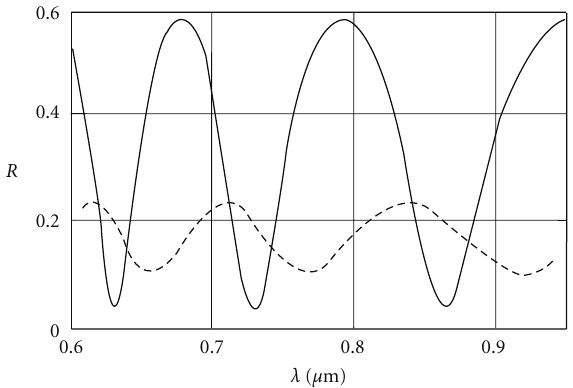
Figure 5: Reflectance spectrum of a transparent film on a metal substrate (solid line) and on a nonabsorbing substrate (dashed